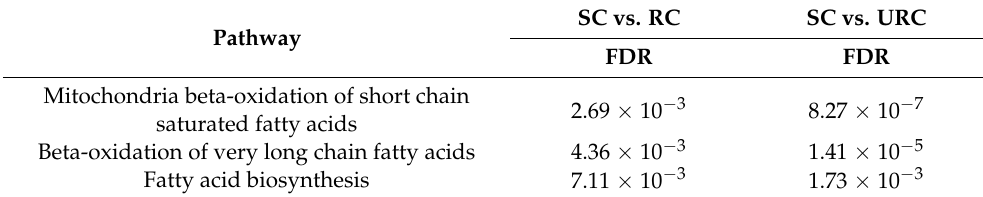
Table 4. Active metabolic pathways in participants who consumed the simple carb diet compared to refined and unrefined carb diets. SC vs. RC Pathway Mitochondria beta-oxidation of short